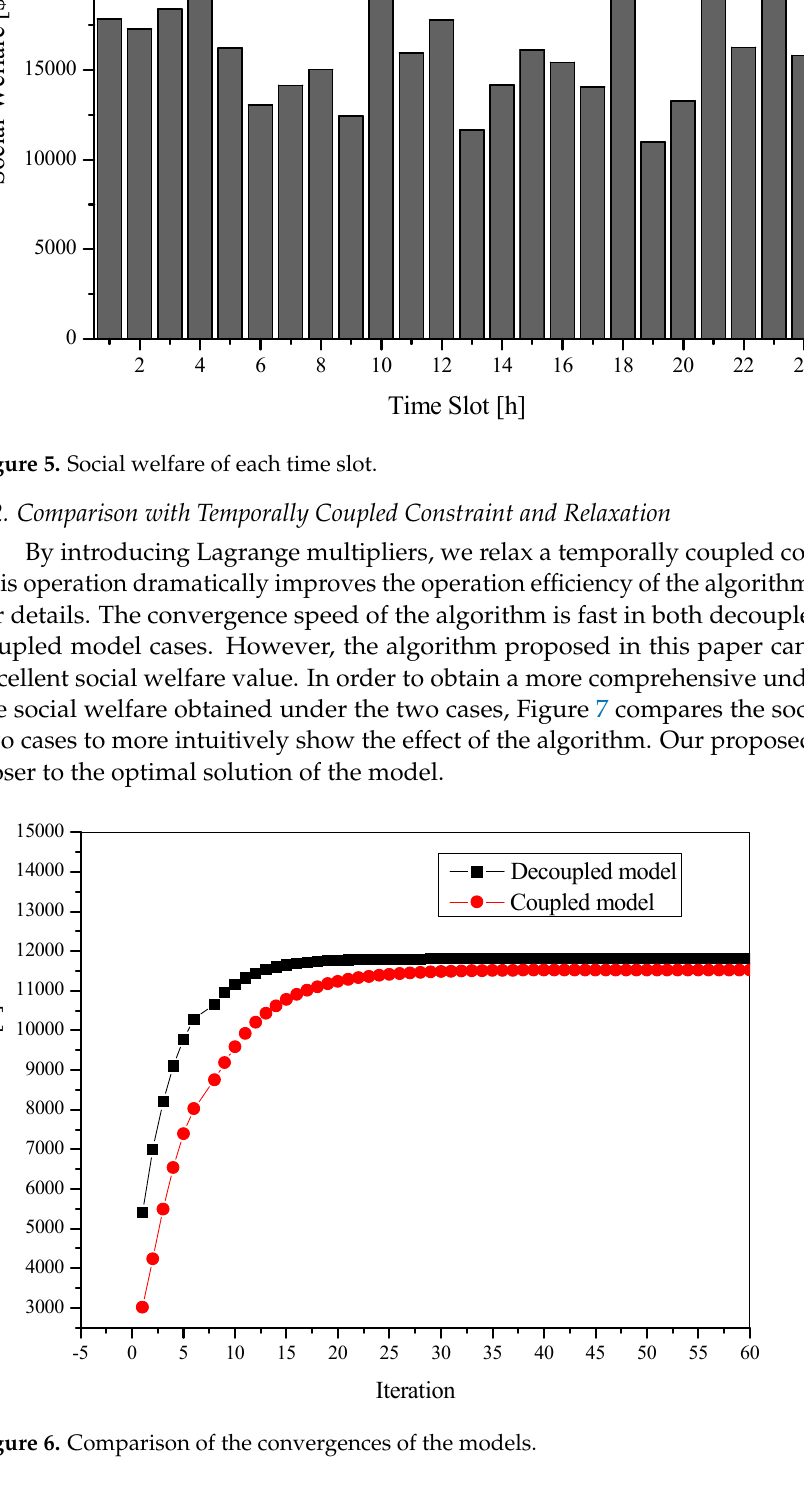
Figure 7. Comparison of the social welfare of two cases. 6.3. Contrast Reflects the Role of MIP The scenario we considered contains EVs under cyber-attack. If the unstable factors are not found out in time, this causes serious consequences. Next, we discuss it in two cases. In one situation, the EVs attacked by the network are not identified, leading to two consequences: one is that the optimal total power consumption (OTPC) of the users ex- ceeds the actual power consumption (Unidentified-1), and the other is that the OTPC of the users is lower than the actual power consumption (Unidentified-2). Comparisons of convergence of electricity prices and social welfare values in cases Identified, Unidenti- fied-1, and Unidentified-2 are shown in Figure 8 and Figure 9, respectively. The Uniden- tified-1 case results in a higher electricity price than the actual value. On the EP side, this leads to excess power production and waste of power. Users need to pay more for using the same amount of power. The loss of benefits for users and EPs results in the reduction of social welfare value. Conversely, in the Unidentified-2 case, the price decreases, also hurting EPs and users. Similarly, the value of social welfare falls.